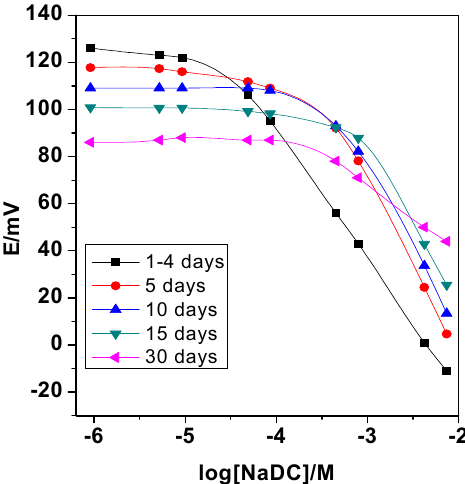
Figure 5. Life-span of the proposed deoxycholate membrane based sensor.